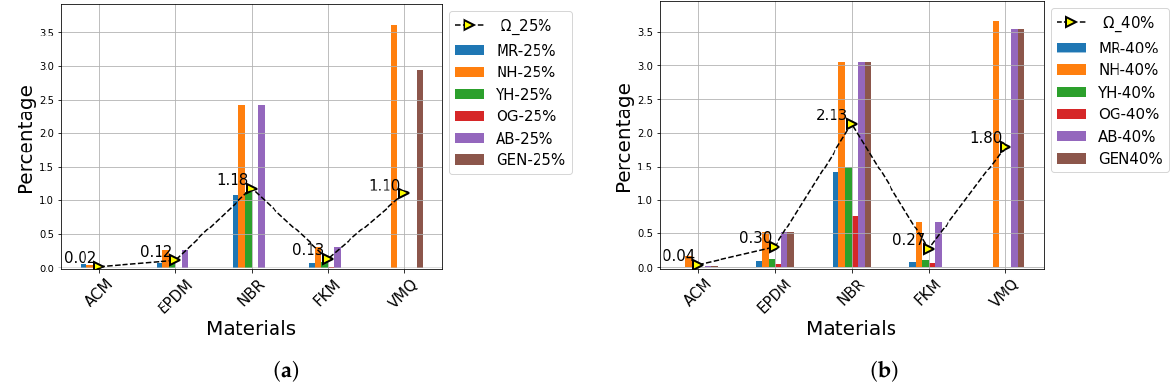
Figure 7. Simulation error analysis on each hyperlastic model’s performance on the materials ( a ) 25% displacement, ( b ) 40%